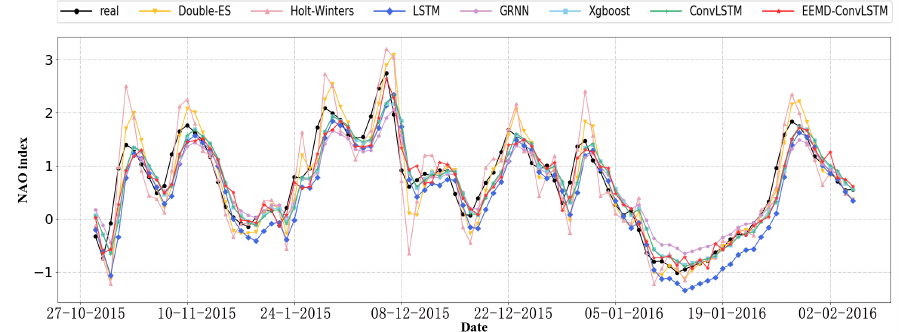
Figure 8. The 100-day prediction results of different